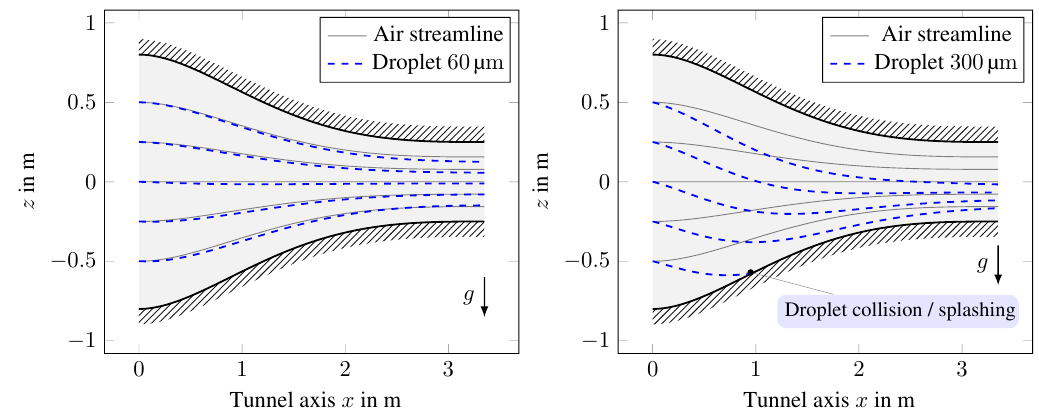
Figure 7. Droplet trajectories in the wind tunnel nozzle and their deviation from the air streamlines under the influence of gravity. Large droplets may collide with the tunnel walls thereby altering the droplet size